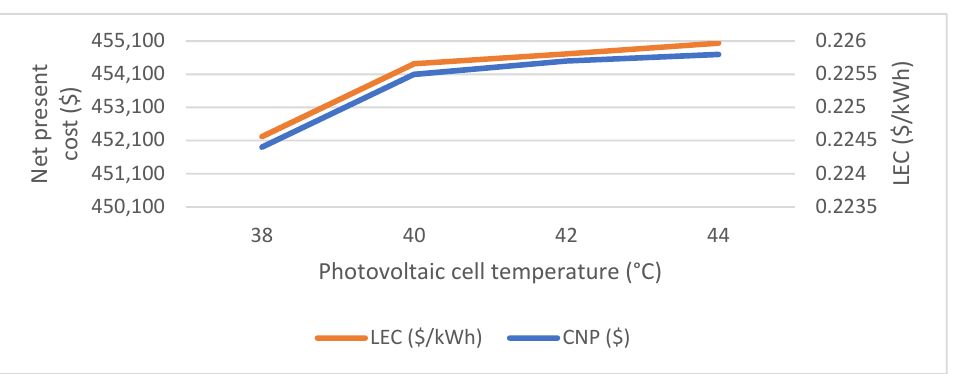
when photovoltaic cell temperature is increased from 38 °C to 44 °C. Similarly, the lev- elized energy cost (LEC) increases from 0.2244 $/kWh to 0.2258 $/kWh considering the above temperature change. When the photovoltaic cell temperature is increased from 38 °C to 40 °C, then 0.48% of net present cost is increased. Likewise, from 40 °C to 42 °C,